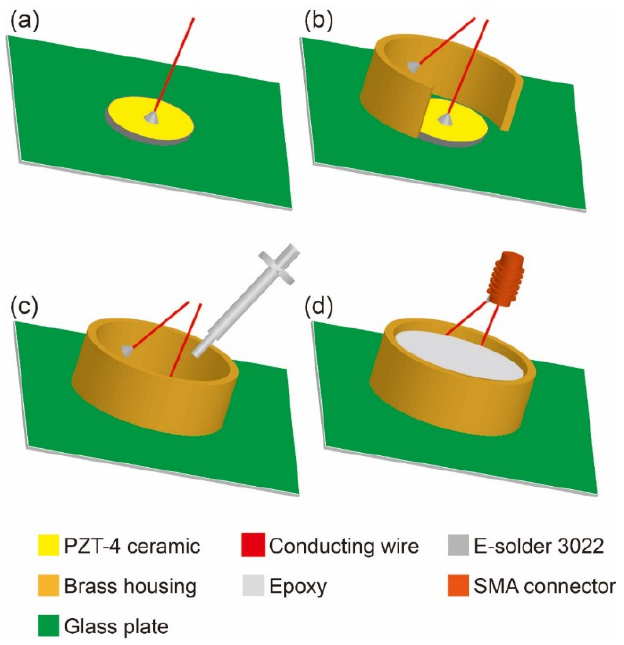
Figure 1. Schematic of the 5 MHz ultrasonic transducer manufacturing process ( a – d ). According to Formulas (1) and (2), we can calculate the center frequency f c and − 6 dB bandwidth BW% of the 5 MHz PZT-4 ultrasonic